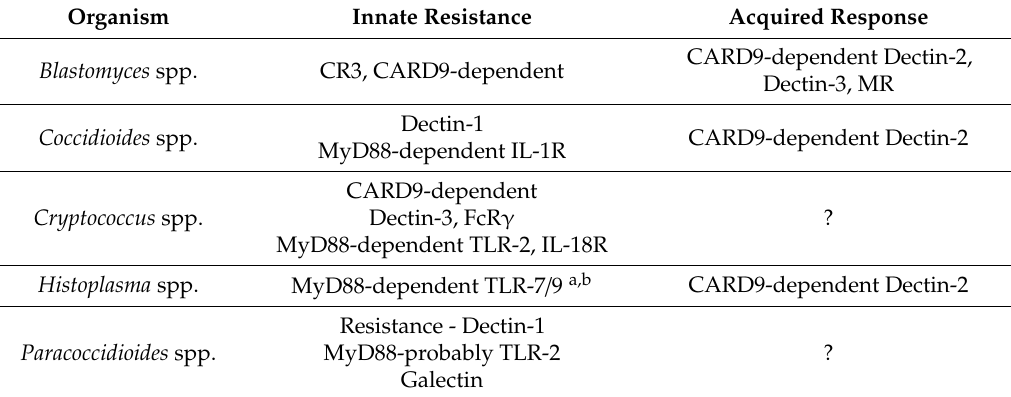
Table 2. Summary of innate immune receptors in fungal infections. Organism Innate Resistance Acquired Response CARD9-dependent Dectin-2, Blastomyces spp. CR3, CARD9-dependent Dectin-3, MR Dectin-1 Coccidioides spp. CARD9-dependent Dectin-2 MyD88-dependent IL-1R CARD9-dependent Cryptococcus spp. Dectin-3, FcR γ ? MyD88-dependent TLR-2, IL-18R Histoplasma spp. MyD88-dependent TLR-7 / 9 a,b CARD9-dependent Dectin-2 Paracoccidioides